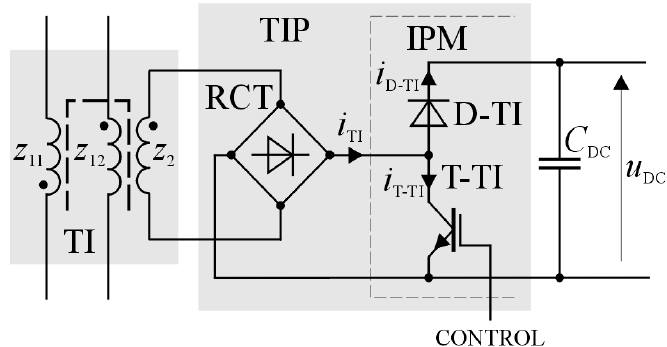
Figure 5. Diagram showing the implementation of the tuned inductor in the model of the PSP (RCT–fast diode rectifier).